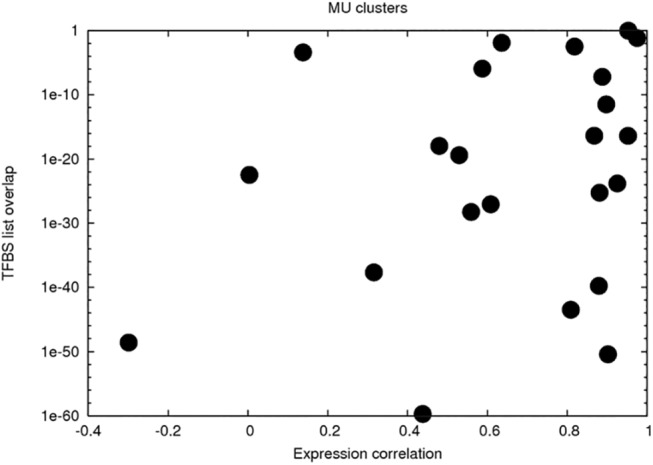
Relation between expression and promoter similarities.The x-axis is for Pearson correlation coefficients of average gene expression profiles of human vs mouse gene group pairs. The y-axis is for p-value of overlap of their TFBS-s lists.